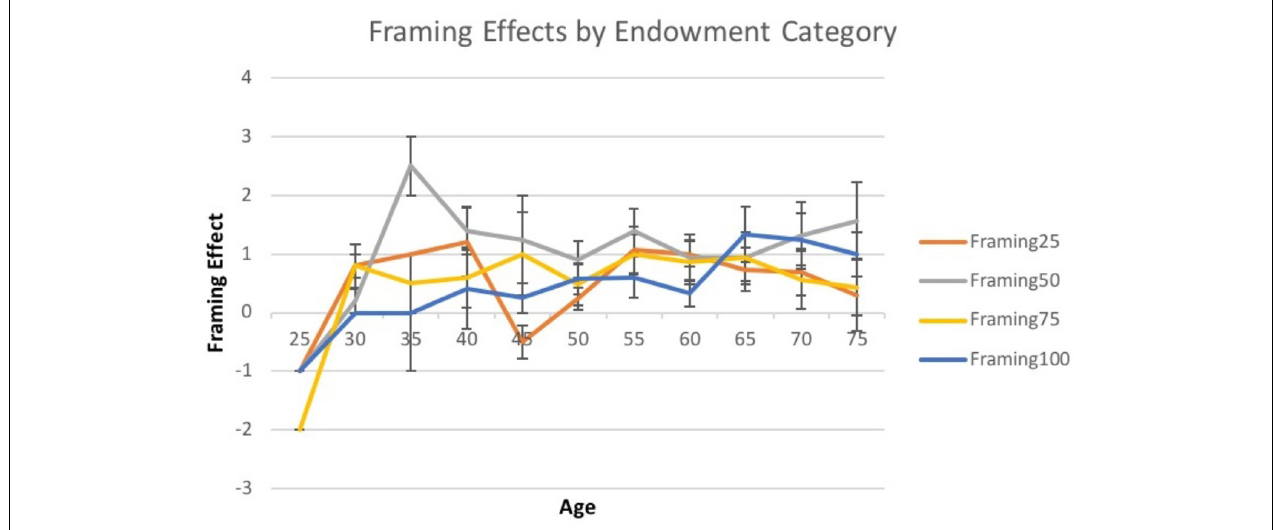
FIGURE 4 | Framing effects across age by endowment category. A line graph of framing effects in each endowment category across age at 5 years intervals. The amount deviation from 0 in framing effects represents the amount of susceptibility to framing bias. Each colored line represents the mean of framing effects in a different endowment category for every 5 years. Every mean for each of 5 years also shows standard error bars. The difference of framing effects across age was only significant in the $100 category [ t (1,100) = 2.56, p = 0.01].